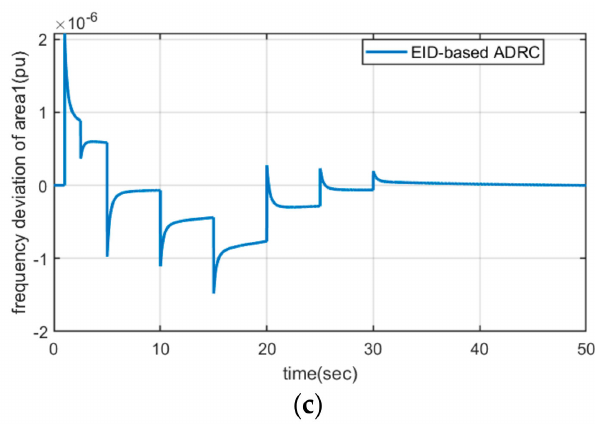
Figure 7. Dynamic response of Area 1, ( a ) load variation; ( b ) frequency deviations of Area 1 with di ff erent controller; ( c ) enlarged view under EID.